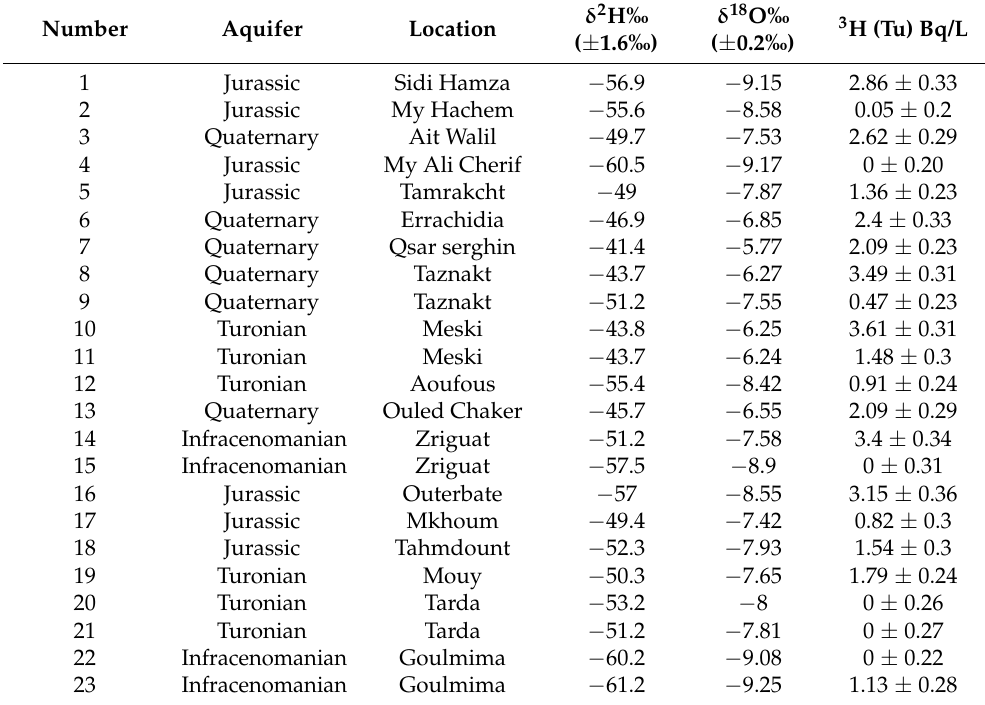
Table 3. Isotopic data of sampled waters with the average uncertainties (isotopic analyses relative to